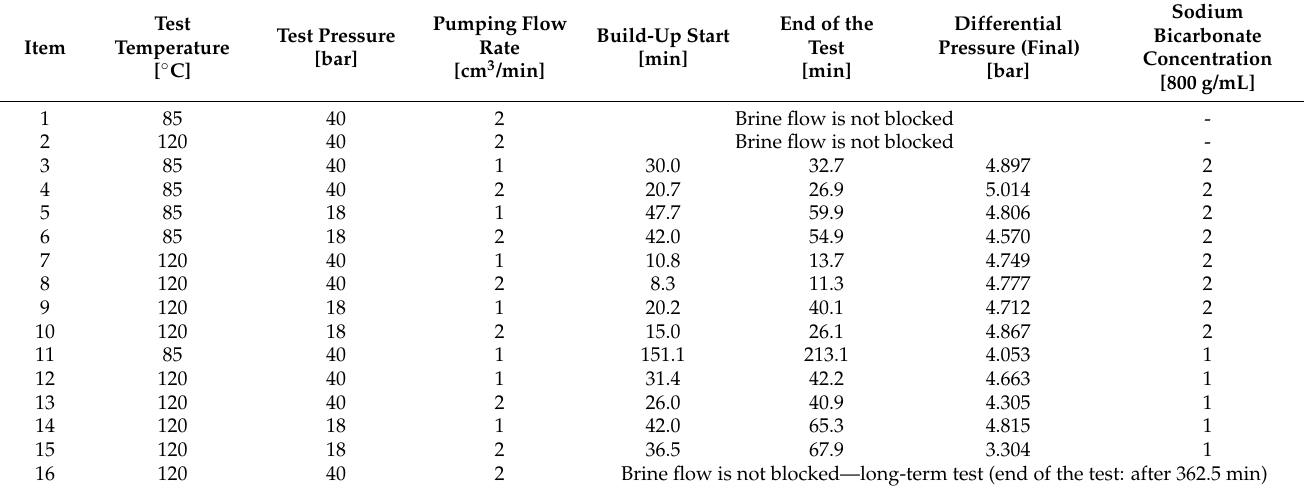
Table 2. Sediment precipitation in geothermal waters measurement